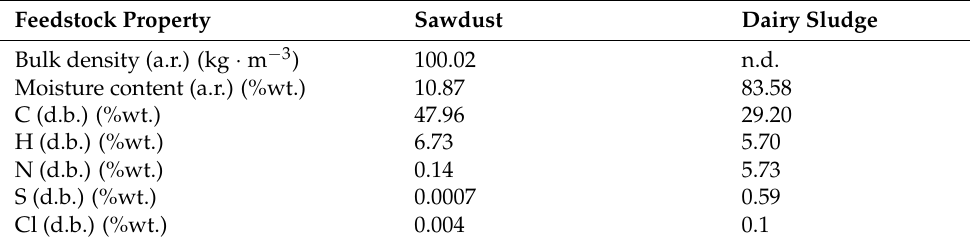
Table 2. Feedstock’s physical and chemical properties. Feedstock